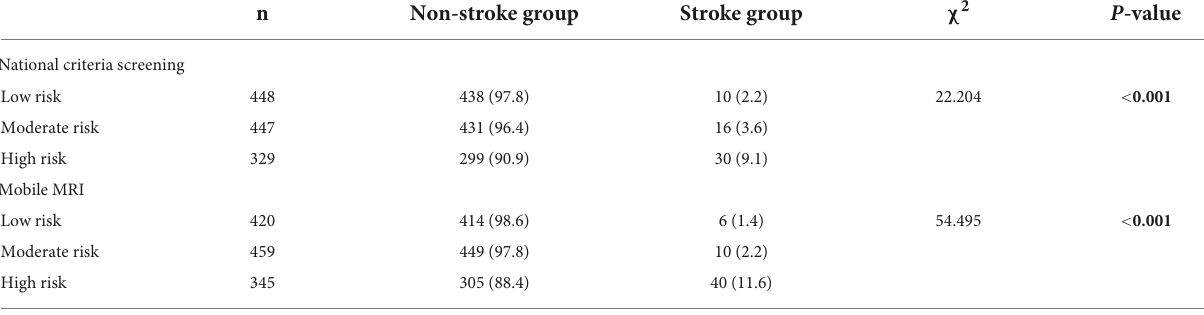
TABLE 2 Comparison of end point events among different risk groups under national stroke criteria and mobile MRI screening. n